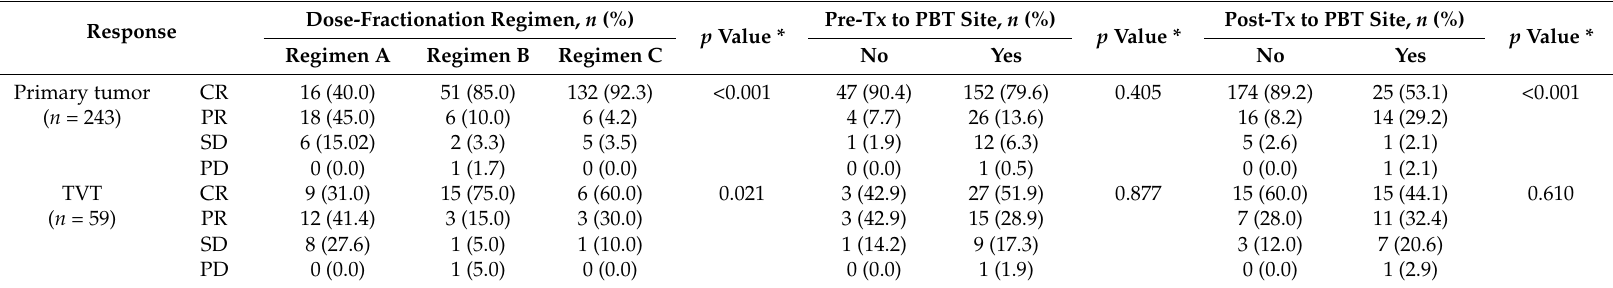
Table 2. Primary tumor and tumor vascular thrombosis (TVT) response according to dose-fractionation regimens and pre- and post-treatment (Tx).